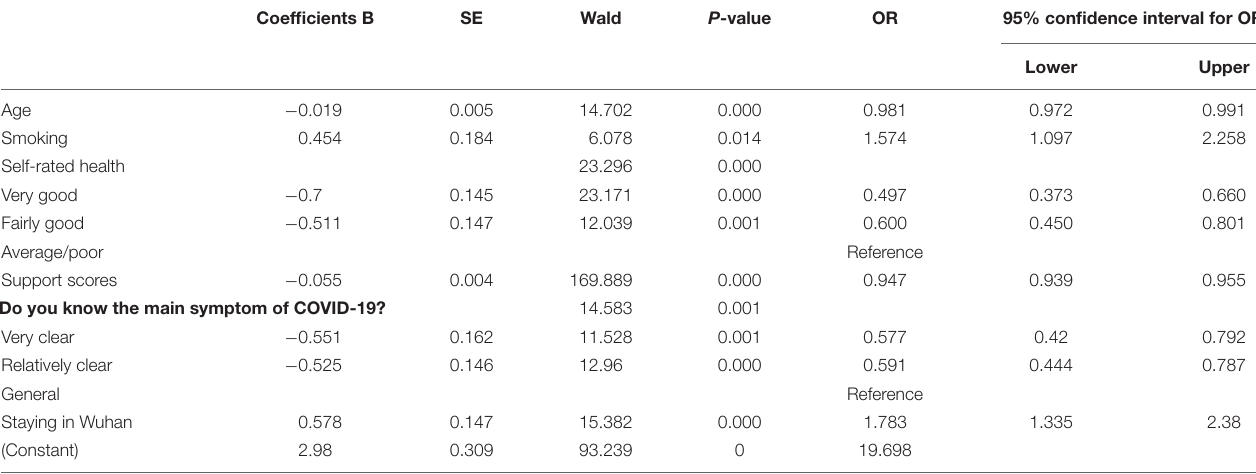
TABLE 3 | Multivariable logistic analyses for factors related to depressive